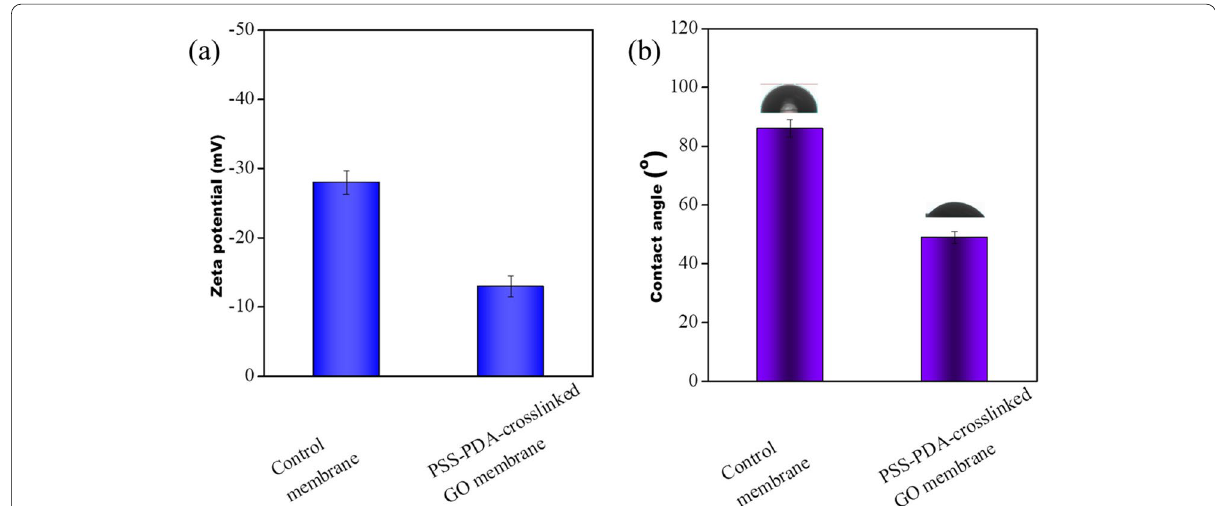
Fig. 8 Control and PSS-PDA-crosslinked GO membranes’ Zeta potential ( a ) and Contact angle ( b )